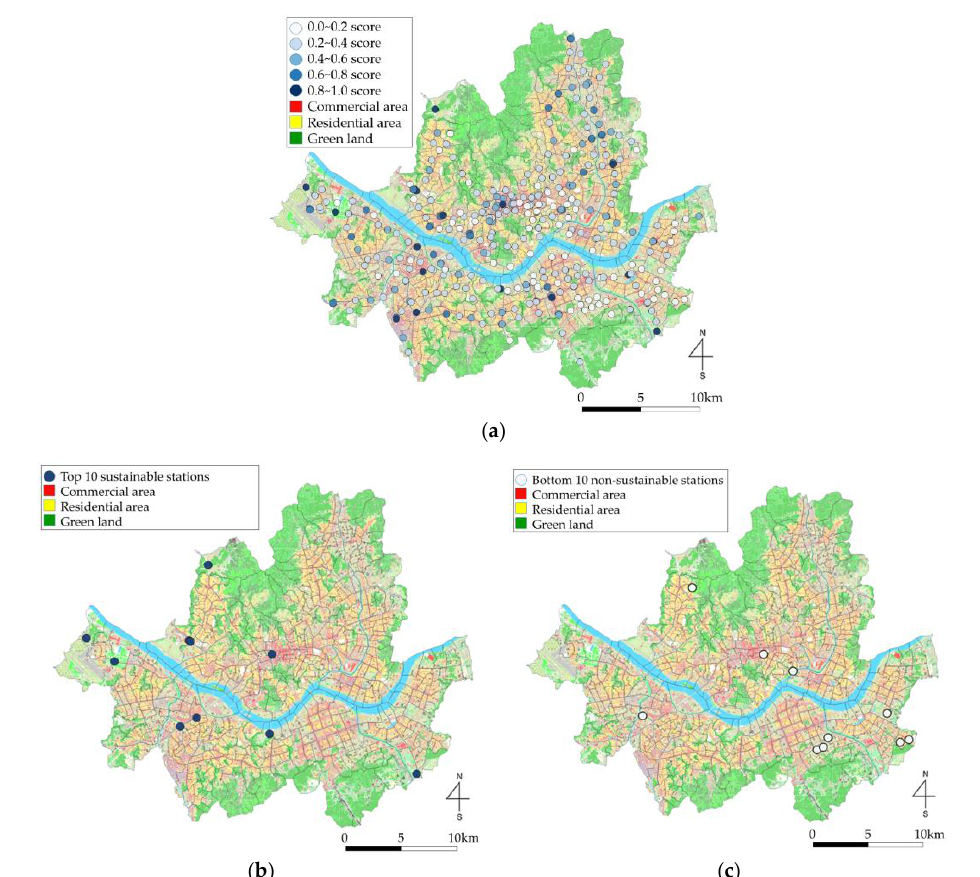
Figure 3. Visualization of the efficiency evaluation results for Seoul: ( a ) efficiency result of the 352 stations; ( b ) top 10 efficient stations; and ( c ) bottom 10 inefficient stations.